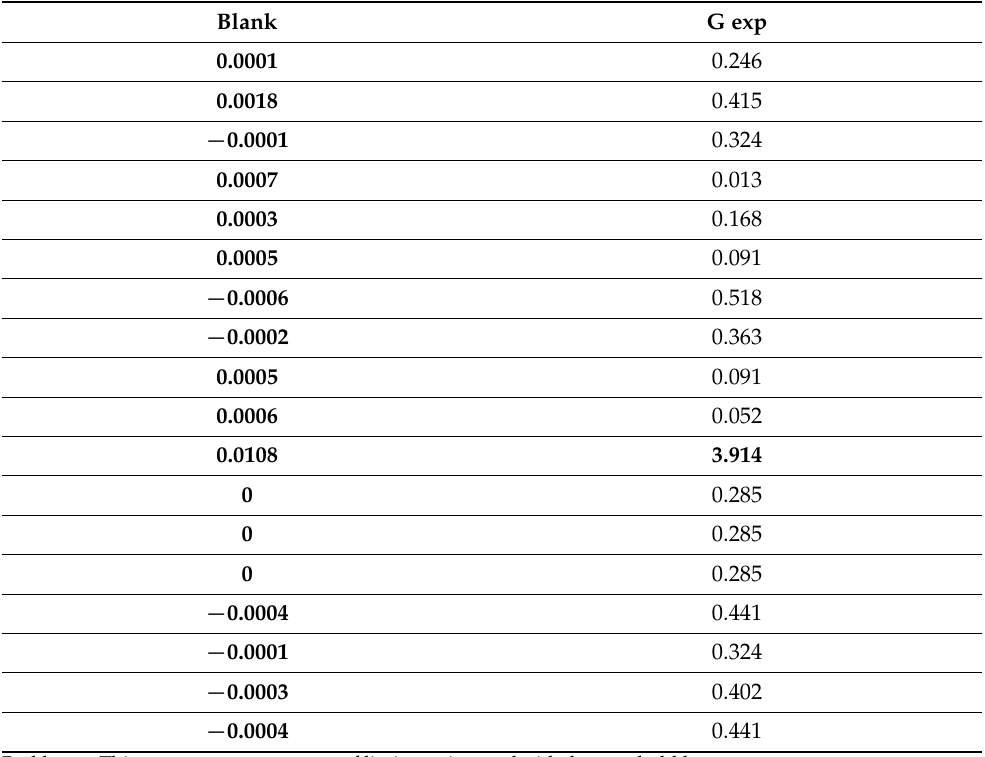
Table 6. Results for blank runs and G exp